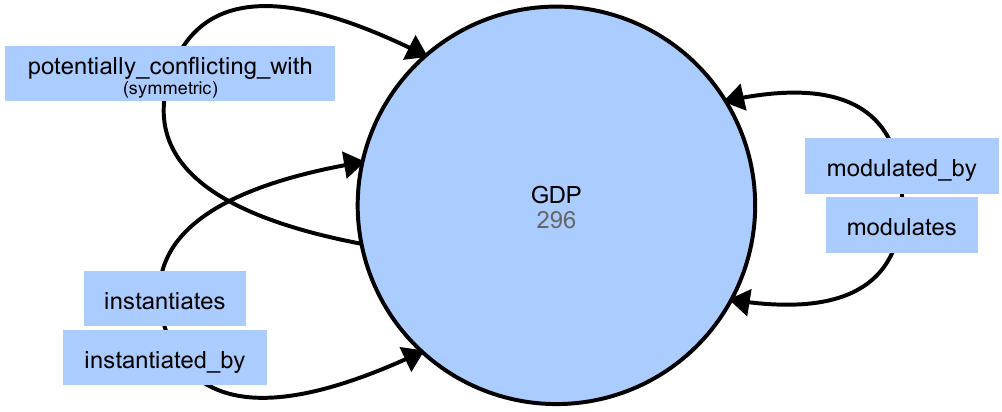
Figure 7. Game Design Pattern ontology